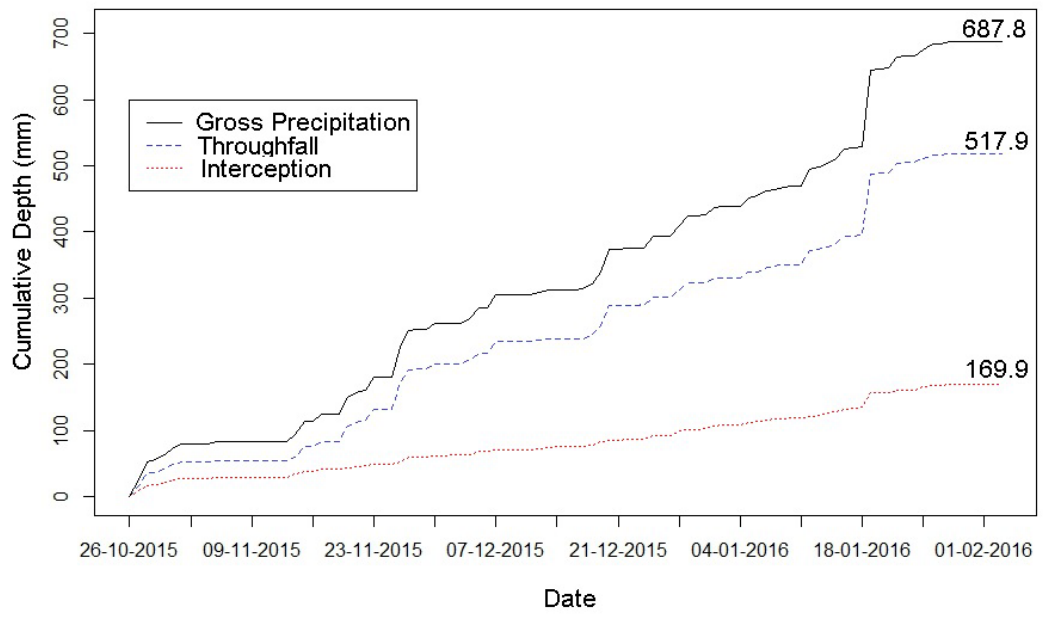
Figure 7. Gross precipitation, throughfall and interception time series from the Cerrado gallery forest.